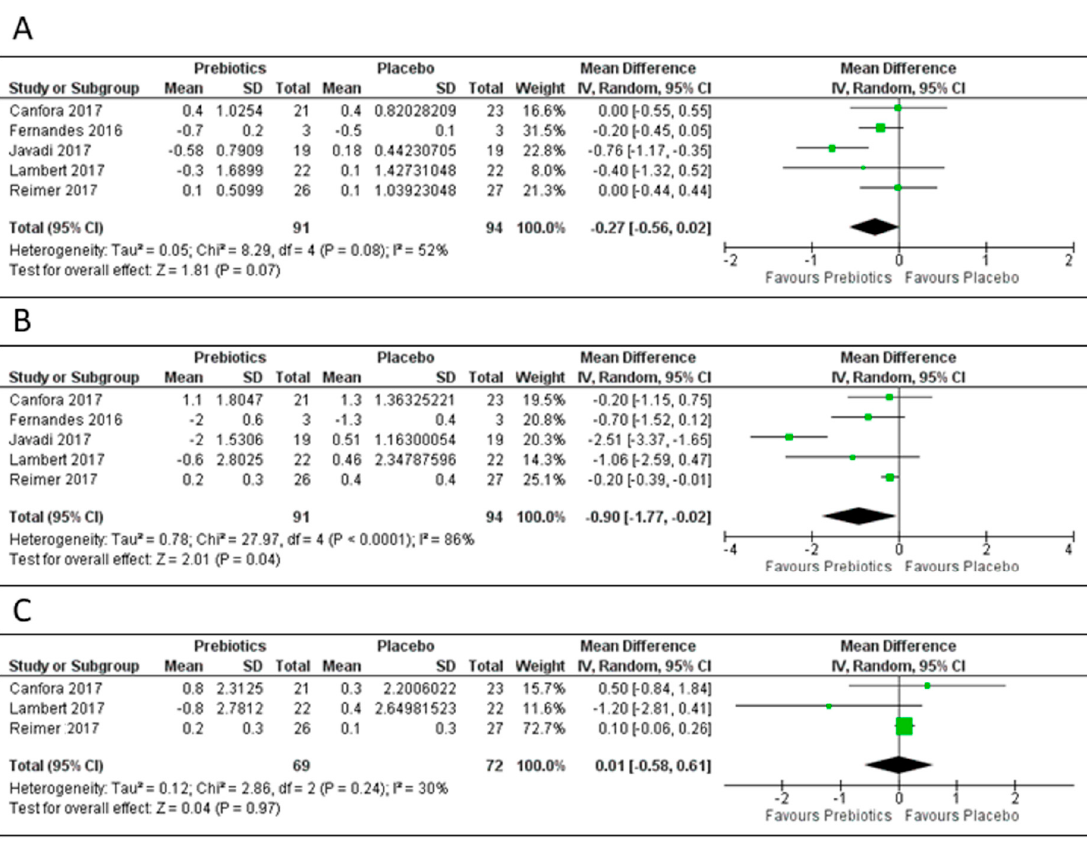
Figure 5. Forest plot of effect of prebiotics on: ( A ) BMI; ( B ) body weight; ( C ) fat mass. Data synthesis using the random effects model for the mean differences in body mass index (BMI), body weight and fat mass for the included randomized controlled trials of prebiotics versus placebo. Prebiotics intervention was found to trend towards a reduction in BMI in five studies with a MD = − 0.27 ((95% CI − 0.56, 0.02), p = 0.07) (Figure 5A), while the reduction in body weight in five studies was significant (MD = − 0.90 kg (95% CI − 1.77, − 0.02), p = 0.04), Figure 5B. The prebiotics did not change the fat mass when compared to the placebo in three clinical trials, Figure